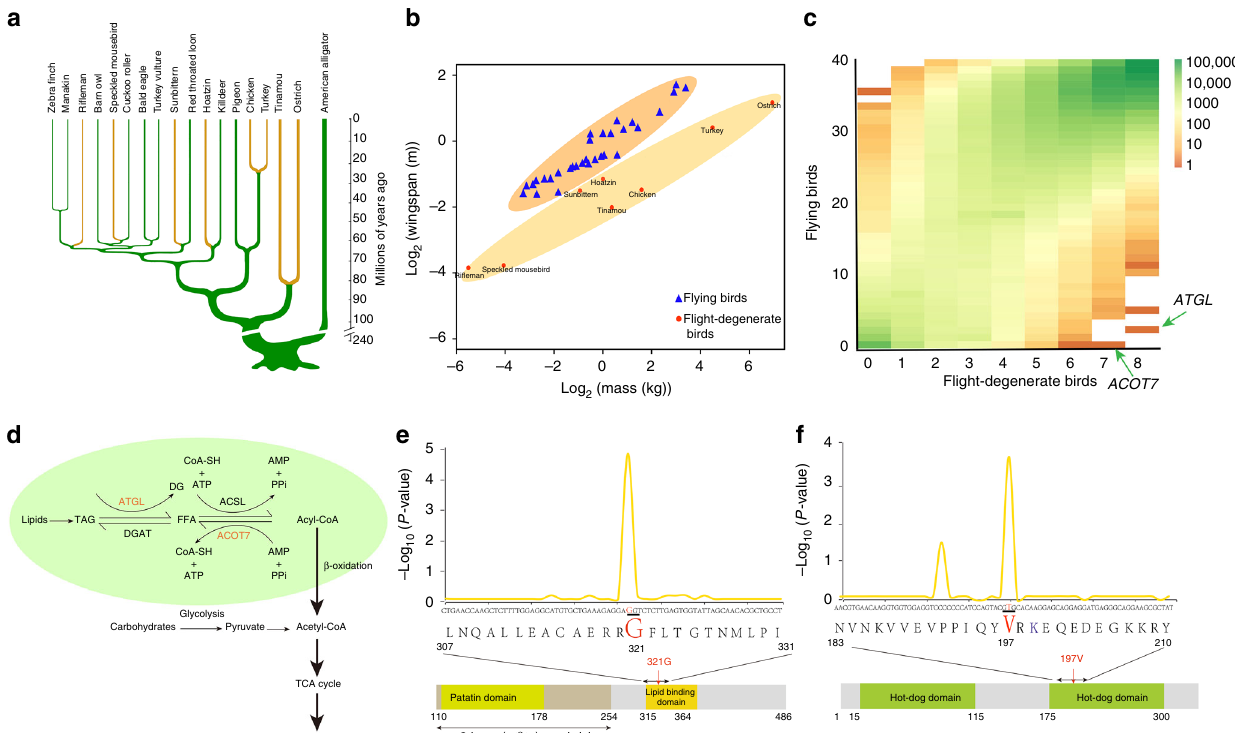
Fig. 1 Identi fi cation of convergent evolutionary sites in fl ight-degenerate birds. a A phylogeny tree 5 with American alligator as the outrgoup showing the convergence of eight studied fl ight-degenerate bird species. b Flying and fl ight-degenerate species were classi fi ed based on previous literatures and observations (Methods). Flight-degenerate species includes fl ightless birds and weak fl yers. Average body mass of each species is plotted against its average wingspan measurement. c Two-dimensional frequency spectrum for nucleotides in fl ying and fl ight-degenerate species. The nucleotide frequencies of fl ight-degenerate birds were plotted against those of fl ying birds. The x -axis means the nucleotide counts among the eight fl ight-degenerate bird species and the y -axis means the nucleotide counts among 40 fl ying bird species. The number of loci is color-coded according to the scale on the right. d The pathway in which ATGL and ACOT7 are involved 35,70 . The main pathway for lipid metabolism is shadowed. In e and f , the upper shows the signi fi cant values (Fisher ’ s exact test) for the representative nucleotides on ATGL e and ACOT7 f , the middle shows the sequence of amino acids, and the bottom shows the schematic domains. The identi fi ed convergent sites are highlighted in red. Source data are provided as a Source Data fi